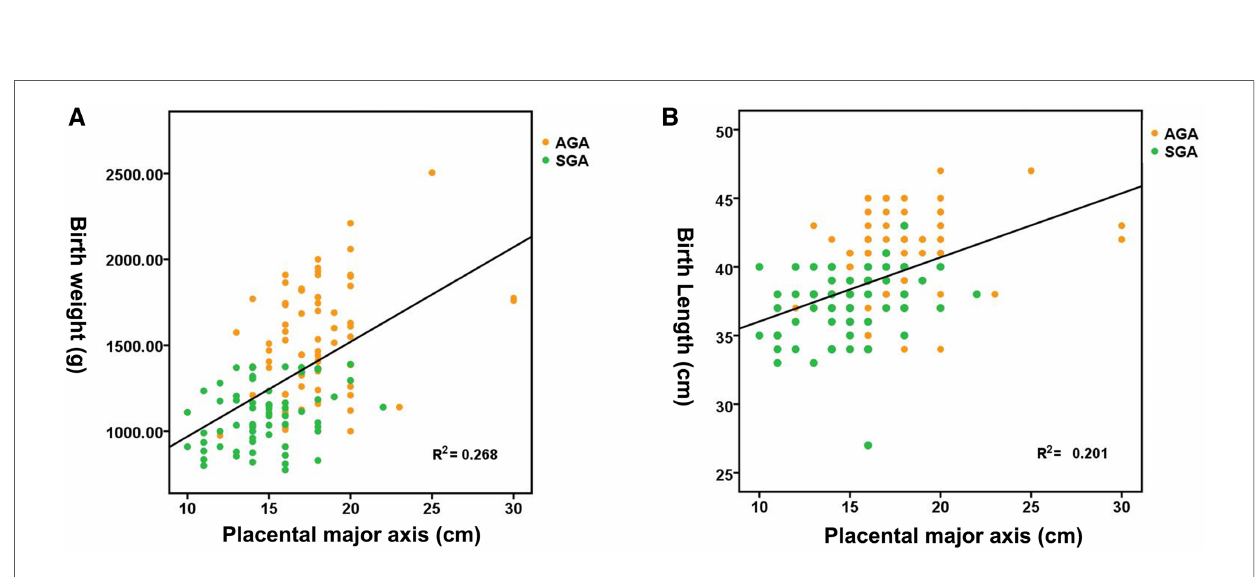
FIGURE 2 Distribution of birth weight (A) and length (B) according to placental major